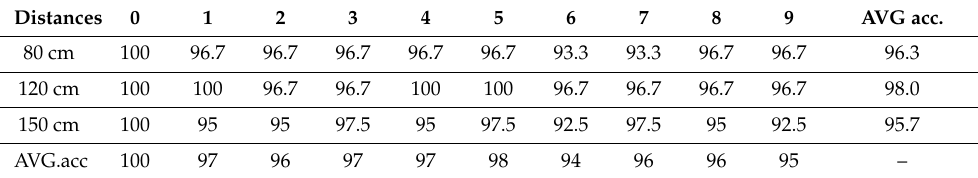
Table 3. The recognition accuracy vs. different distances from the sensor (%).